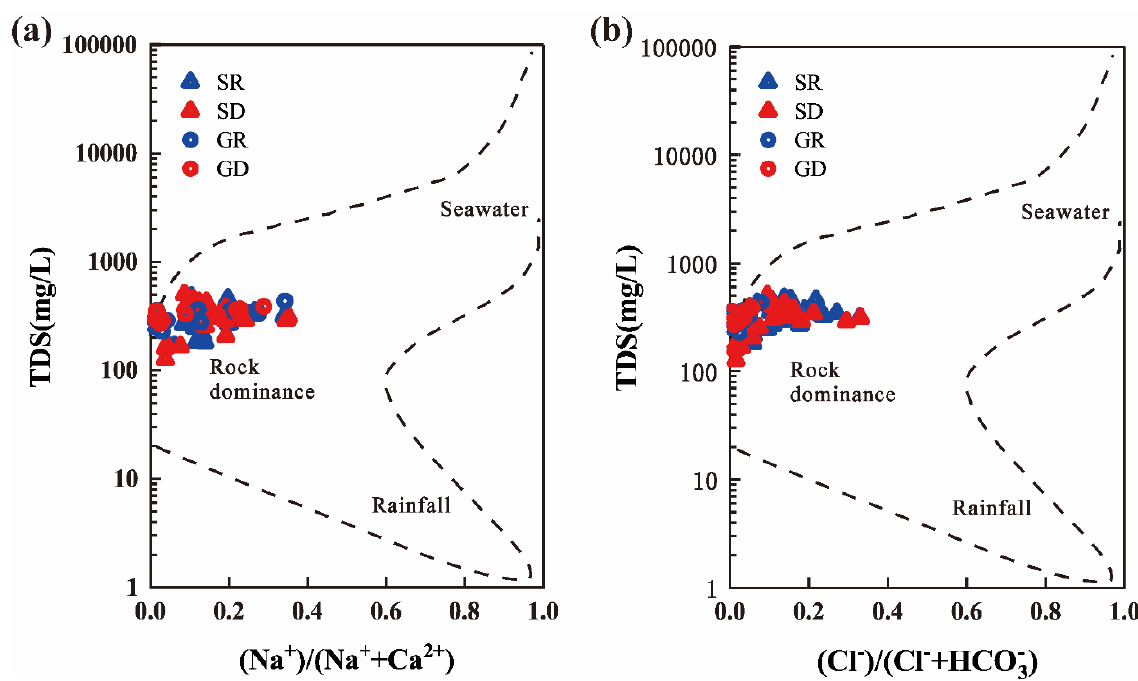
Figure 6. Identification of the main processes on Gibbs diagrams (adapted from Gibbs 1970) according to ( a ) the Na and Ca ratio ( left ) and ( b ) the Cl and HCO 3 ratio ( right ).